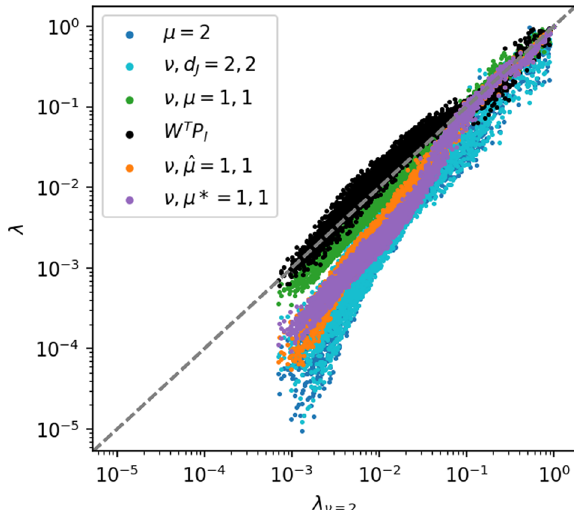
Fig. 9 Eigenvalues of the sensitivity matrix. A scatter plot showing eigenvalues, λ , of the sensitivity matrix for 50 randomly chosen liquid environments from the HEA dataset. The fi rst six eigenvalues are not shown. The grey dashed line indicates y = x . The eigenvalues have been scaled, so that the largest eigenvalue for each environment is